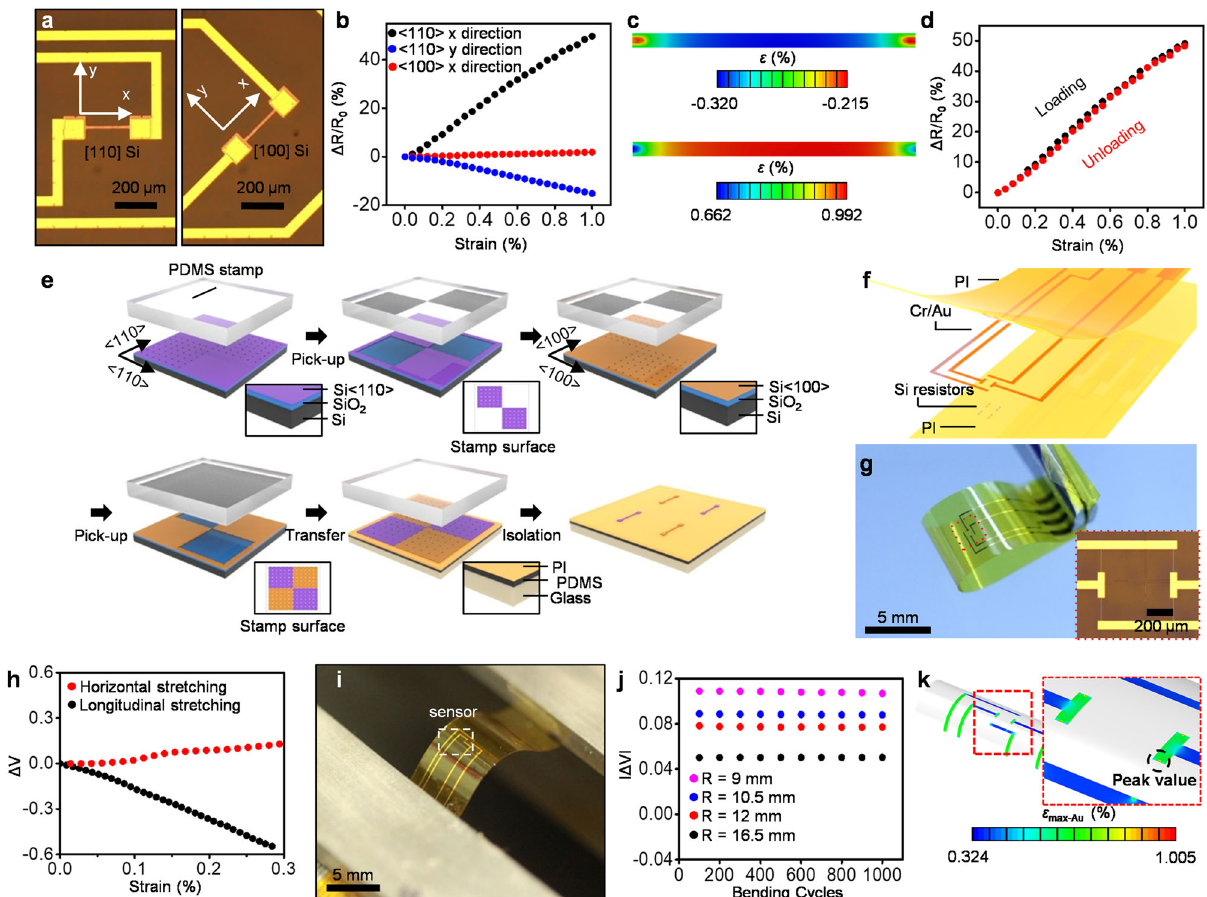
Fig. 2 Behavior of the piezoresistive sensor under mechanical deformation. a Optical image of the single crystalline silicon piezoresistors in two orientations, [110] and [100], yielding sensitivity differences. b Fractional changes in resistance as the function of longitudinal and transverse strain variation; the slope represents the sensing behavior and gauge factor. c Computed strain distributions in a piezoresistor for the 1% strain, applied to the fl exible polyimide substrate, in the horizontal (up) and longitudinal (down) direction. d Response of the [110] silicon piezoresistor to the application and the release of longitudinal strain. e Schematic of the fabrication of the strain gauge in a Wheatstone bridge con fi guration using two [110] and two [100] silicon piezoresistors on a 12.5 µm thick polyimide substrate. f Exploded view highlighting the key sensing element and functional layers of the strain gauge in a thin sheet geometry with total thickness of ~15 µm. g Optical photograph of the piezoresistive sensor. The inset shows an enlarged view of the red dotted box showing the piezoresistors in a Wheatstone bridge con fi guration. h Changes in output voltage from a Wheatstone bridge as the function of longitudinal and transverse strain variation. i Optical photograph of the strain gauge during cycles of bending and stretching. j Output voltage from a Wheatstone bridge at different stages of fatigue testing, which involve 1000 cycles of bending at a different radius, as indicated in the legends. k Computed strain distribution of metal interconnection bent with a critical radius of 0.78